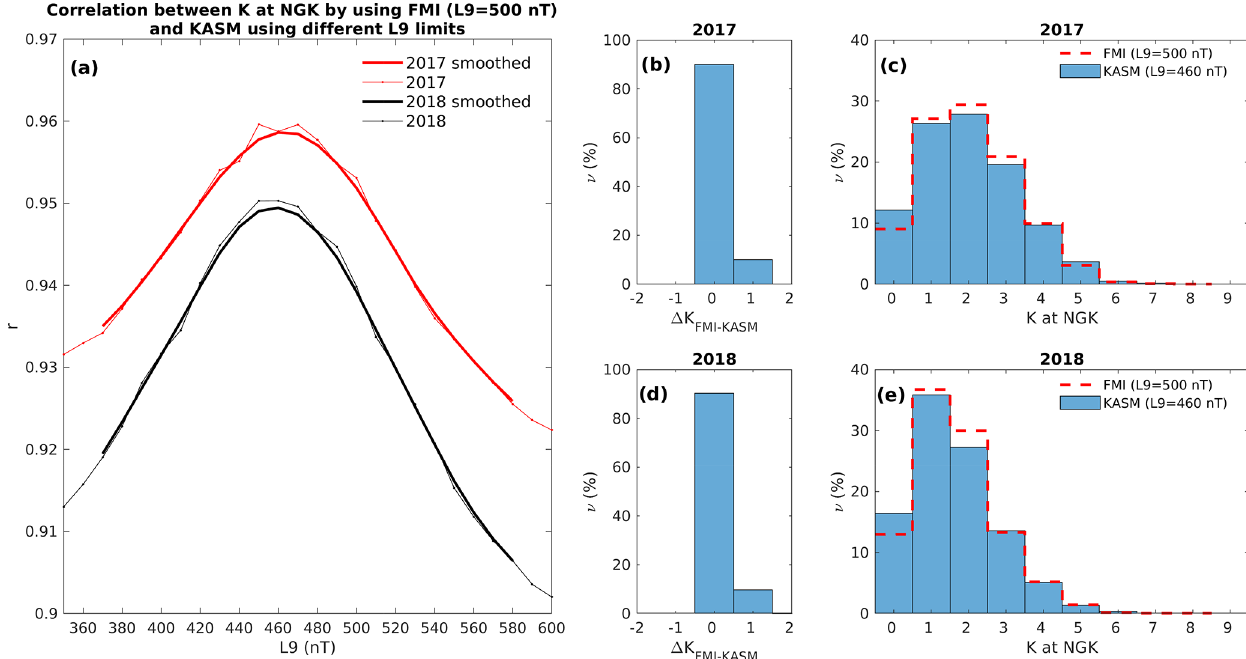
Figure 7. The FMI and KASM consistency test. (a) Correlation analyses between the K index at NGK from FMI with L9 = 500nT and that from KASM for different L9 levels for the years 2017 (definitive NGK 1min data, red) and 2018 (quasi-definitive NGK 1min data, black), respectively. The thick lines are obtained by smoothing the experimental (thin) lines. In each year the maximum correlations are found at L9 = 460nT. The occurrences of (cid:49) K = K FMI − K KASM during 2017 (b) and 2018 (d) . Frequency distributions of the K KASM (460nT) and K FMI (500nT) indices for the years 2017 (c) and 2018 (e) .